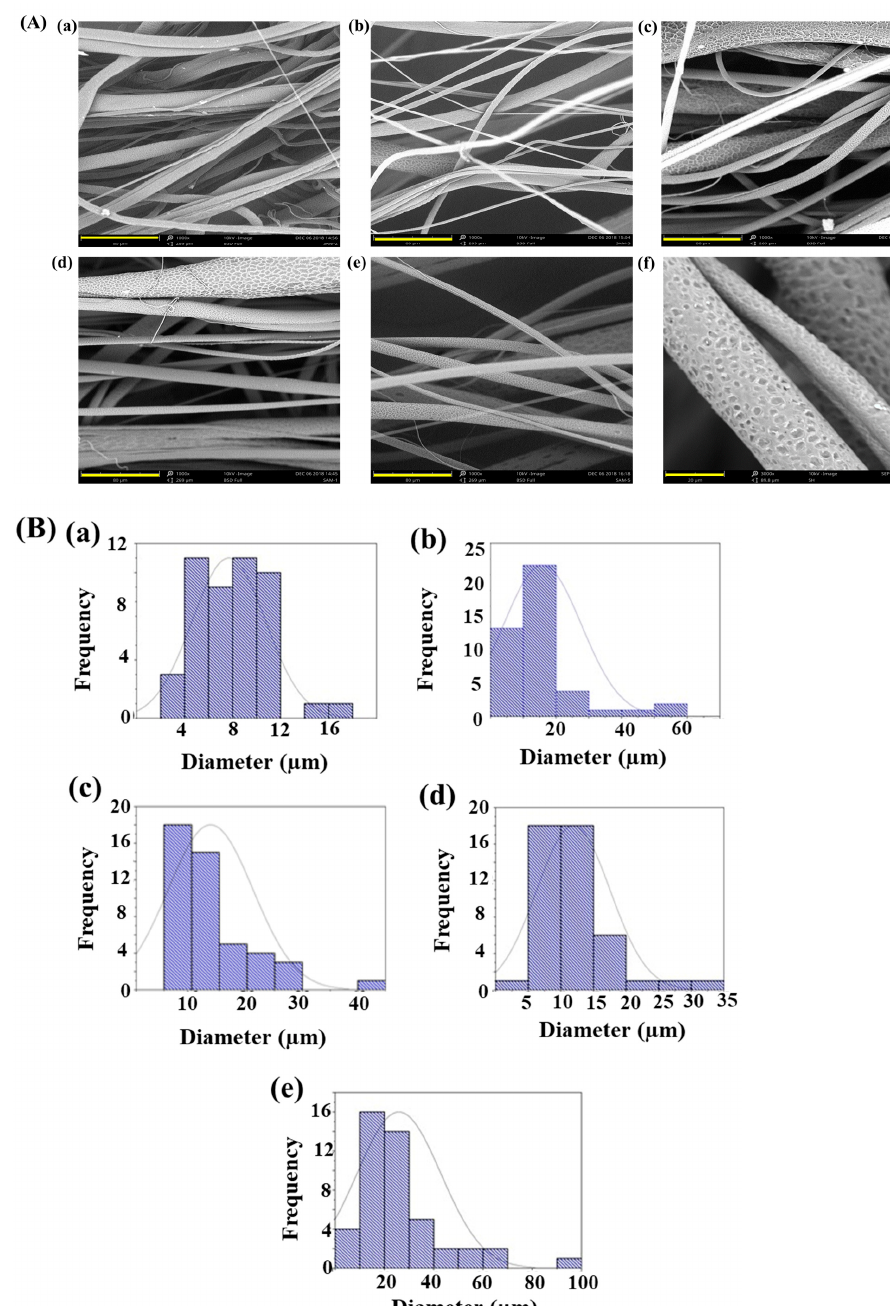
Figure 3. ( A ) SEM observation of c-spun PCL and PCL-CA fibers. ( a ) PCL (Control), ( b ) PCL + 0.5% CA, ( c ) PCL + 1% CA, ( d ) PCL + 1.5% CA, ( e ) PCL + 2% CA and ( f ) an enlarged image of fibers showing porous appearance. Scale bar of ( a – e ) is 80 µ m and scale bar of ( f ) is 20 µ m. ( B ) The diameter distribution plot of c ‐ spun PCL and PCL ‐ CA fibers. ( a ) PCL (Control), ( b ) PCL + 0.5% CA, ( c ) PCL + 1% CA, ( d ) PCL + 1.5% CA, and ( e ) PCL + 2% CA.